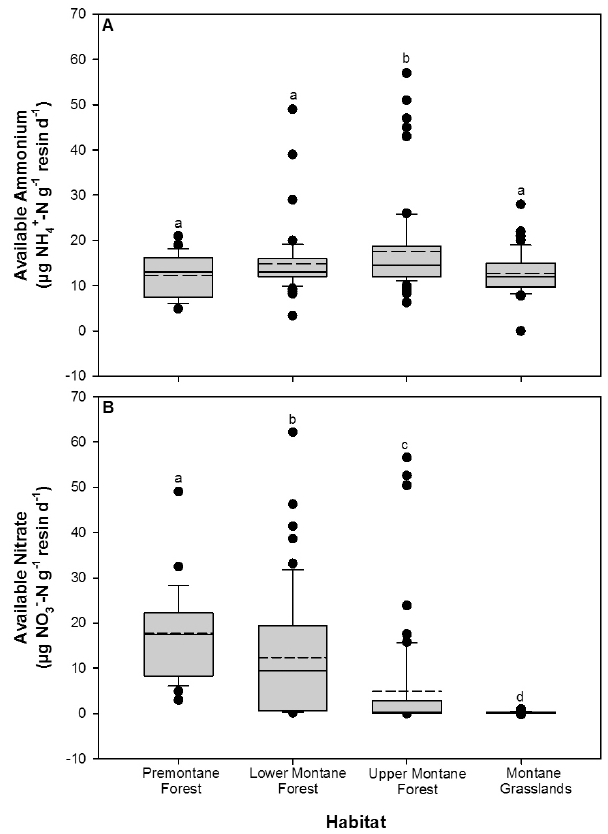
Fig. 3. (A) Available NH + and (B) available NO − fluxes by 4 3 habitat. The short-dash line within each box represents the mean, whereas the solid line represents the median. Boxes enclose the in- terquartile range, whiskers indicate the 90th and 10th percentiles. Kruskal–Wallis ANOVA ( P < 0.05) was used to test for differences among habitats. Lower case letters indicate statistically significant differences among means (Fisher’s LSD on rank transformed data, P <